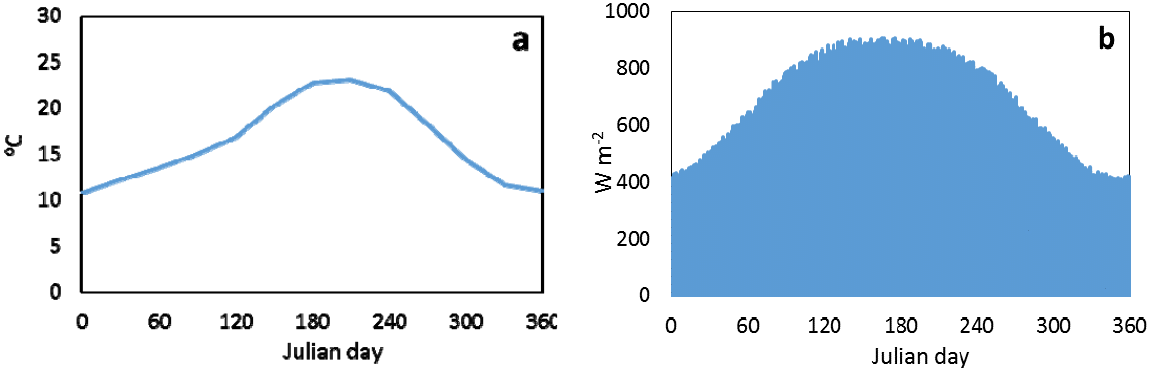
Figure 1. Environmental conditions used to force the model: ( a ) Surface temperature and ( b ) Daily maximum solar